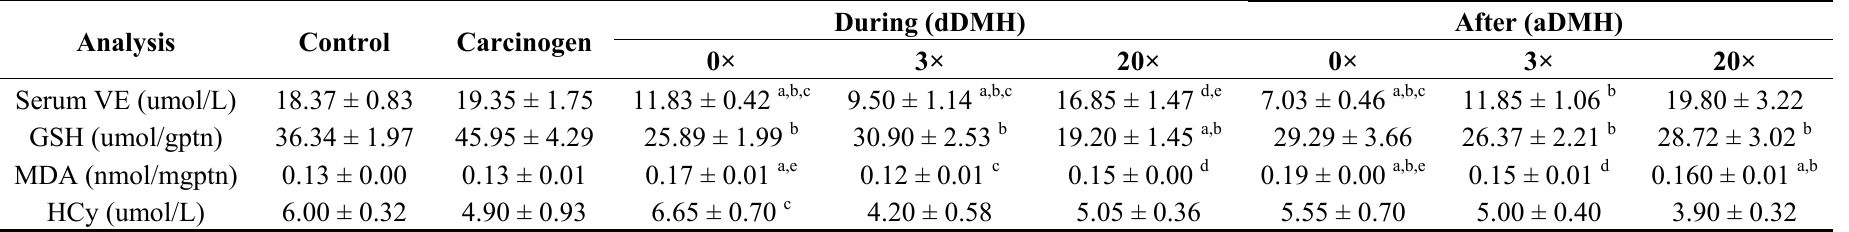
Table 3. Hepatic and serum levels of biochemical oxidative stress biomarkers in rats submitted to different treatments.